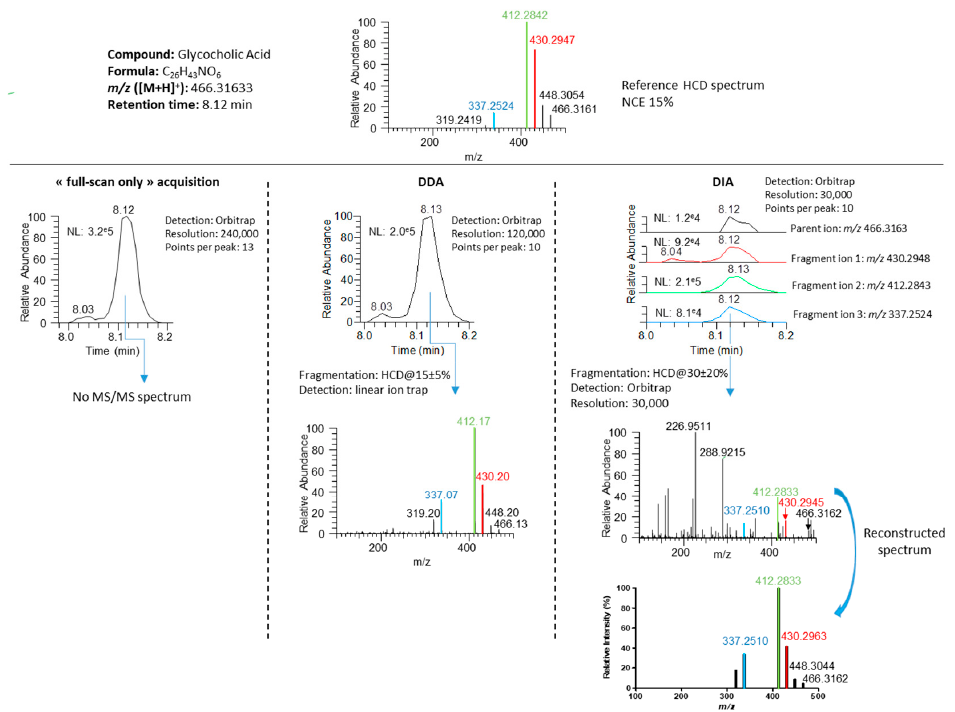
Figure 5. MS and MS/MS data of glycocholic acid obtained with full-scan only, DDA and DIA used NCEs of 15% ± 10% and 30% ± 20%, respectively. DIA MS / MS spectrum of glycocholic acid was workflows. The reference MS/MS spectrum was acquired at an NCE of 15% while DDA and DIA manually reconstructed from relative fragment ion acquisitions used NCEs of 15% ± 10% and 30% ± 20%, respectively. DIA MS/MS spectrum of glycocholic acid was manually reconstructed from relative fragment ion intensities.